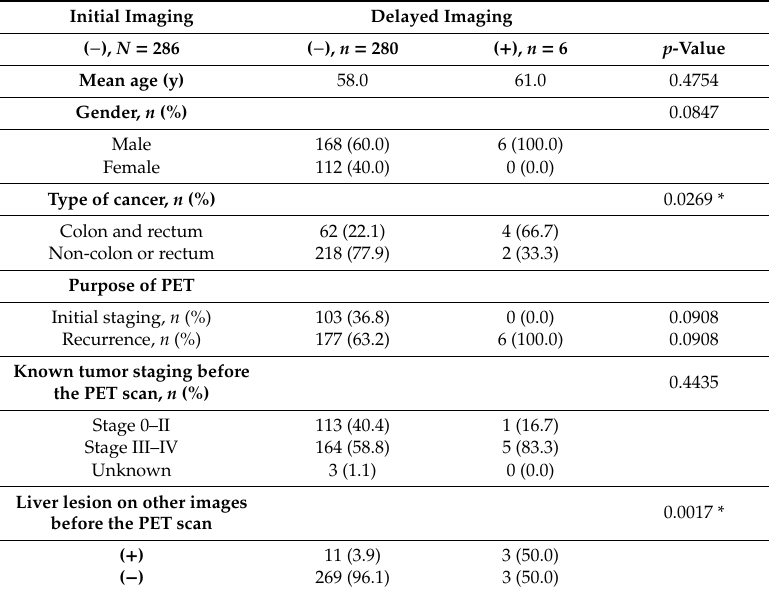
Table 2. Comparison of clinical characteristics of negative and positive liver PET / CT findings on delayed imaging of 286 patients with negative initial liver PET /